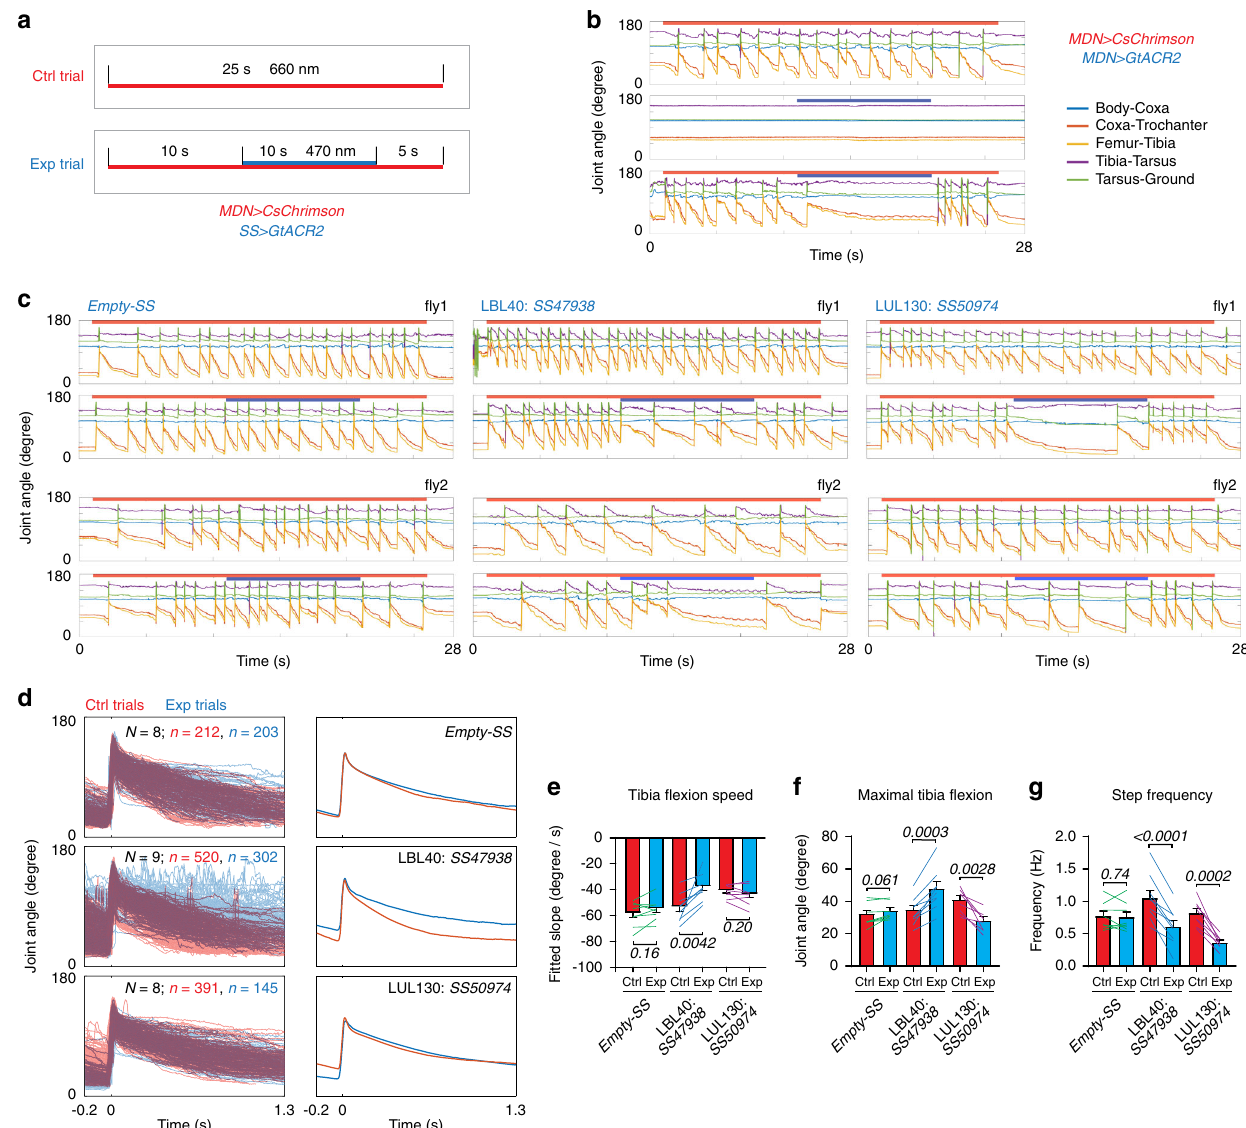
Fig. 7 LBL40 and LUL130 function in the stance and swing phases of backward walking. a Experimental protocol. Each fl y was subject to the same number of control (Ctrl) and experimental (Exp) trials. Red bar indicates red-light stimulus; blue bar indicates blue-light stimulus. b Representative hindleg joint angle time series for positive control fl ies expressing both CsChrimson and GtACR2 in MDN, and stimulated with either red and blue light alone, or both. c Representative hindleg joint angle time series for fl ies of the indicated genotypes. See also Supplementary Movies 10 and 11. d Left: overlaid femur- tibia joint angle from all steps during the 10-s blue-light stimulus in experimental trials (blue), and the corresponding period in control fl ies (red). Right: average of all steps for experimental (blue) and control trials (red). Before averaging, individual traces were truncated if another step occurred within the 1.5 s time window. e – g Slope of femur-tibia joint angle change ( e ) and minimum angle ( f ) during stance phase, and step frequencies ( g ) during the 10-s blue-light stimulus period of experimental trials and the corresponding period of control trials. All data are shown as mean ± s.e.m. across all N fl ies, with colored lines pairing experimental and control values for the same fl y. P values are shown in italics, two-tailed paired t -tests. Source data are provided as a Source Data fi